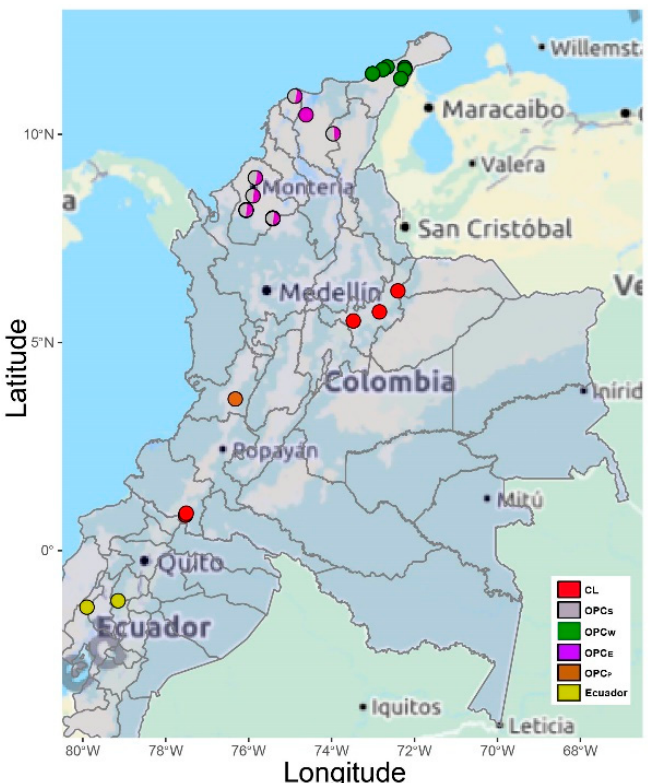
Figure 2. Map of the sampling locations of the five Colombian Creole sheep breeds and Ecuador sheep. Table 1. List of Colombian Creole sheep breeds, typologies and geographical positions. Breed